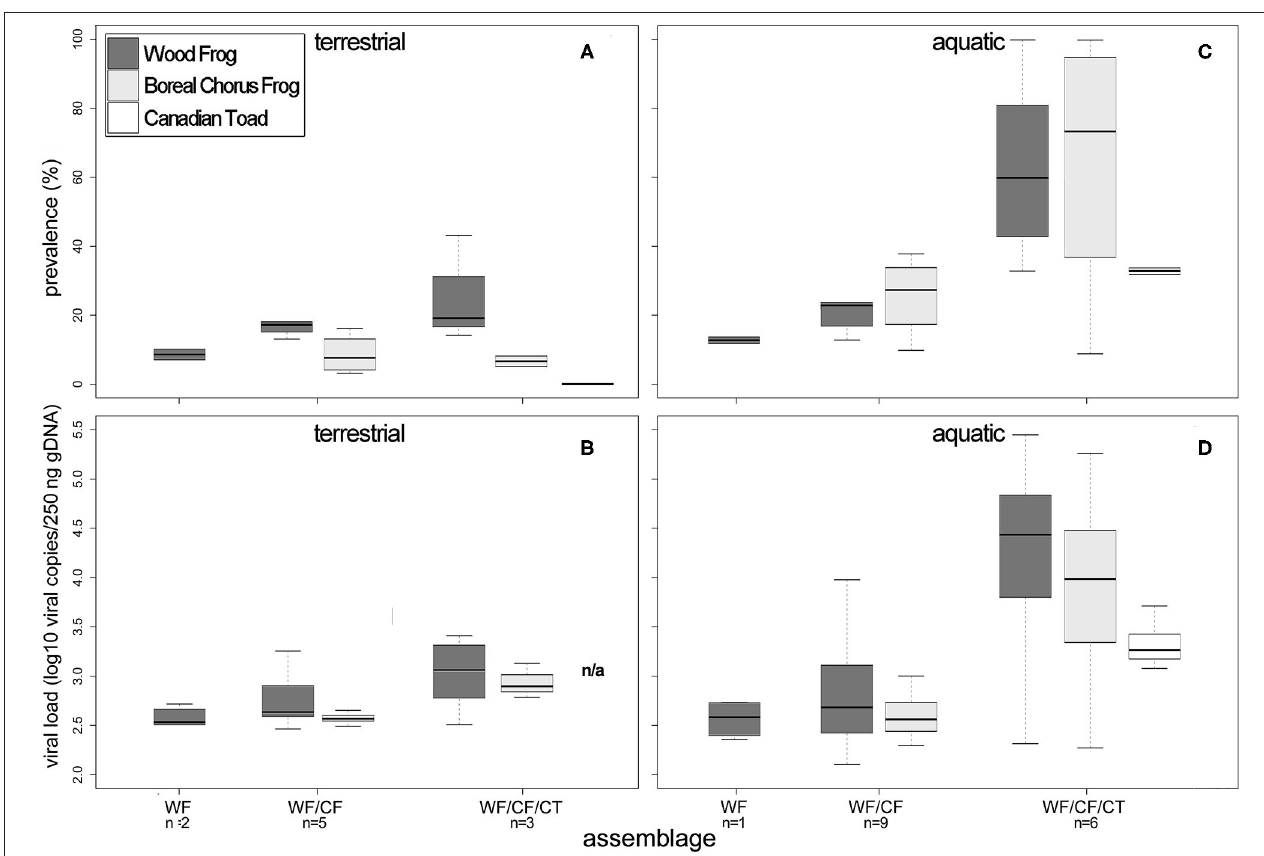
FIGURE 3 | Min/max, median, and inter-quartile ranges of ranavirus infection prevalence (%) and viral load (log10 copies/250 ng of gDNA) in terrestrial (A,B) and aquatic stage (C,D) amphibians in northern Alberta and the Northwest Territories in 2016 and 2017, arranged by community assemblage. The number of sampled communities is stated below the respective assemblage. WF, Wood frog; CF, boreal chorus frog; CT, Canadian